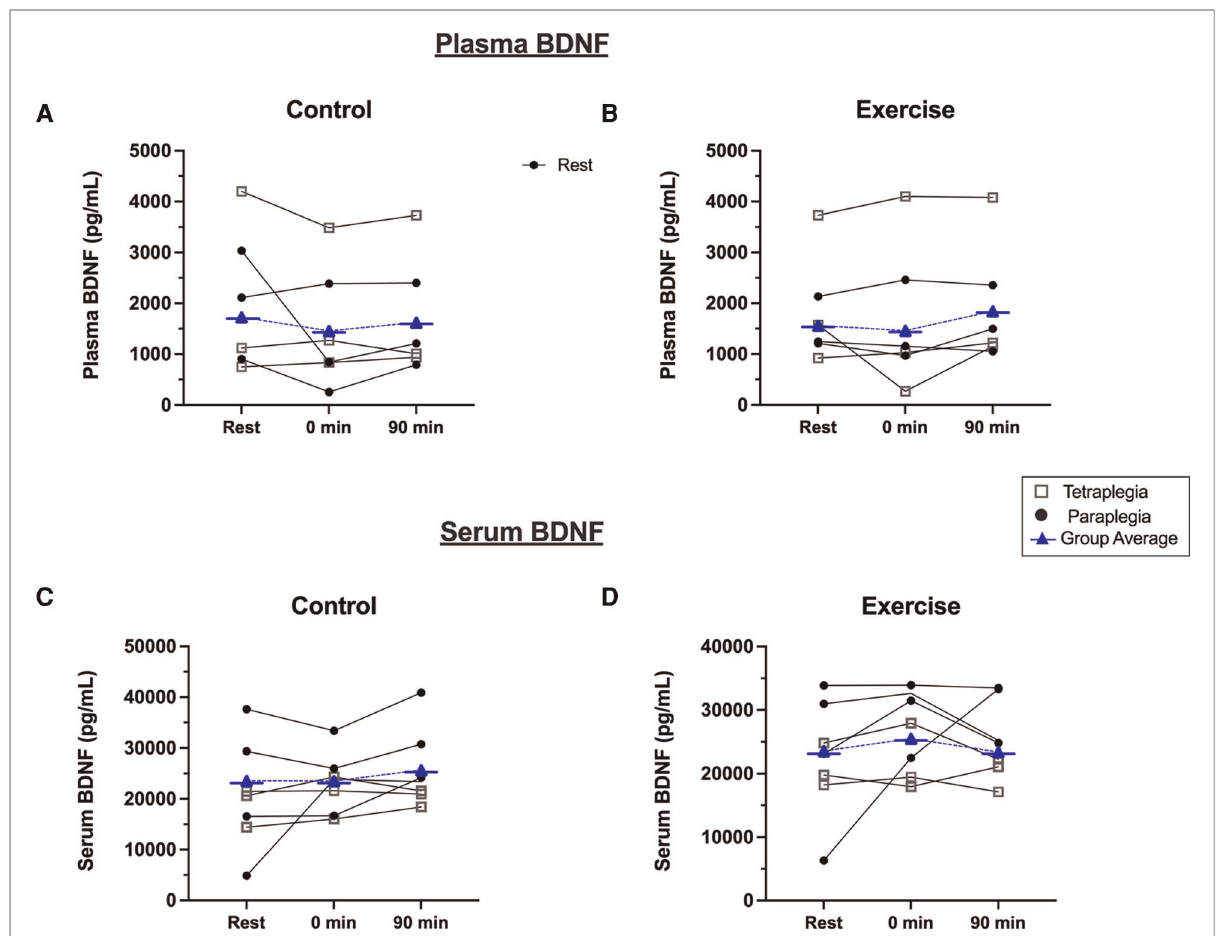
FIGURE 2 Plasma BDNF response to ( A ) seated control, and ( B ) acute exercise. Serum BDNF response to ( C ) seated control, and ( D ) acute exercise. Black dots are individual responses to each condition. Blue symbols represent group mean responses to each